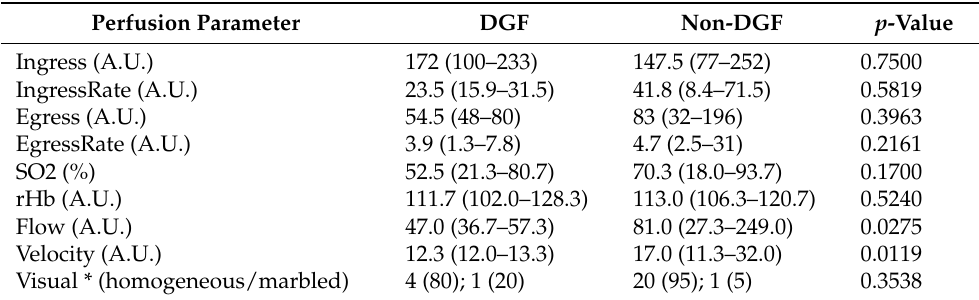
Table 3. Association between intraoperative perfusion assessment of the allograft and delayed graft function (DGF) after kidney transplantation. Quantitative perfusion assessment was performed with ICG fluorescence angiography and O2C.